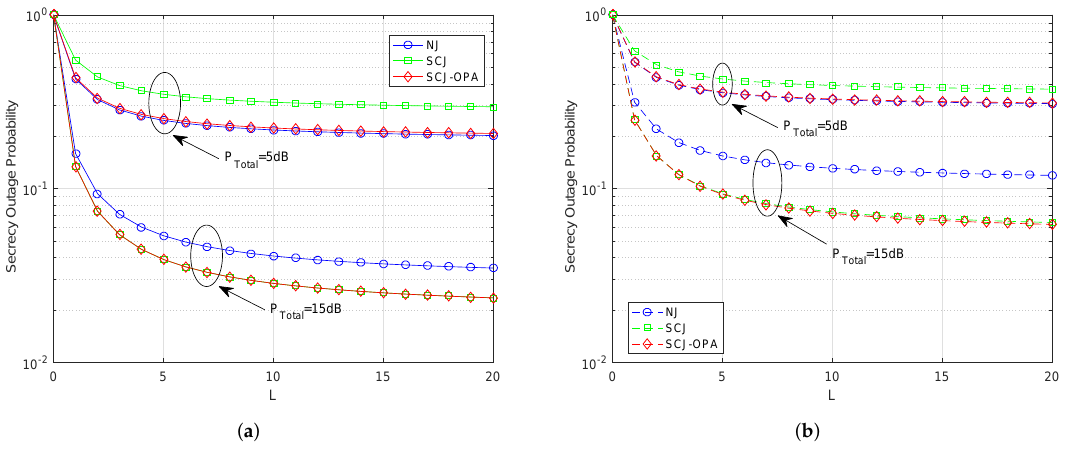
Figure 6. Secrecy outage probability vs. the buffer size L for the three proposed transmission schemes under the NCE ( a ) and CE ( b ) scenarios when R s = 0.5 (bit/s/Hz), M = 2, K = 3, P Total = 5, 15